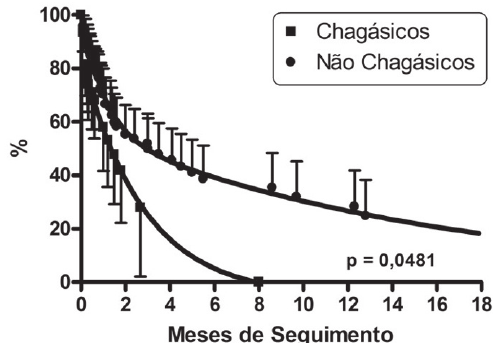
Fig. 3 - Curva de expectativa de vida dos pacientes chagásicos